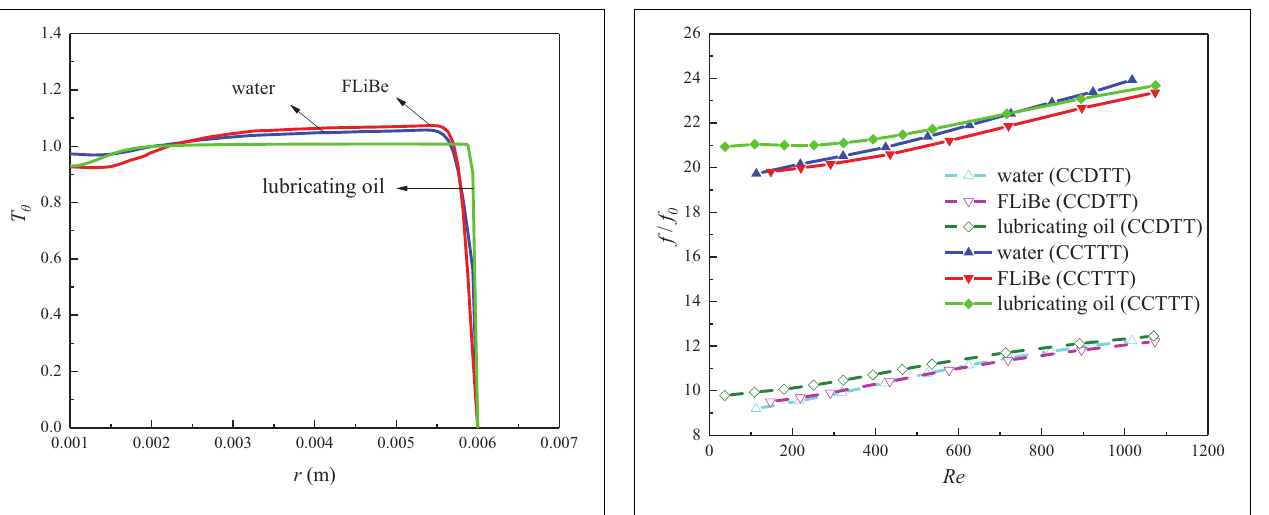
FIGURE 11 | Variation of friction factor ratio with the Reynolds number for various fluids in the tube fitted with CCDTT and CCTTT ( y =